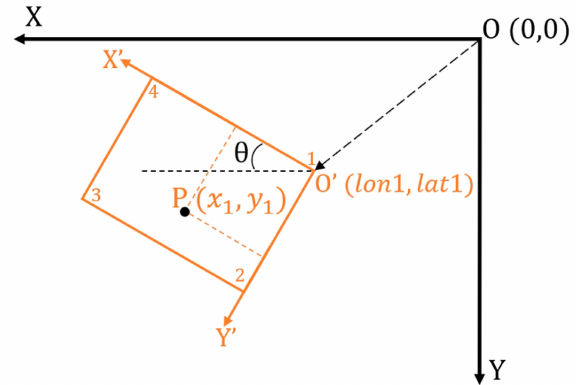
Figure 4. Coordination transformation from GPS coordinates frame to local frame; in which, the x axis and the y axis of the local frame are defined leftward and downward, respectively.